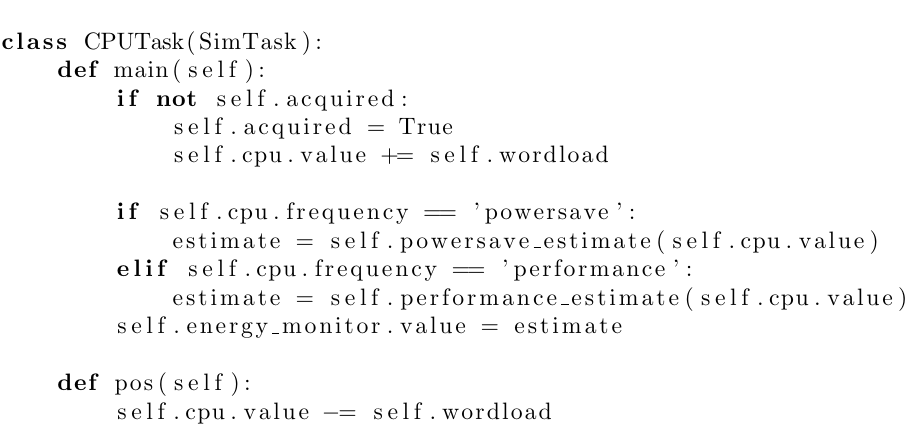
Figure 12. Example implementation of a task to update the energy monitor based on CPU